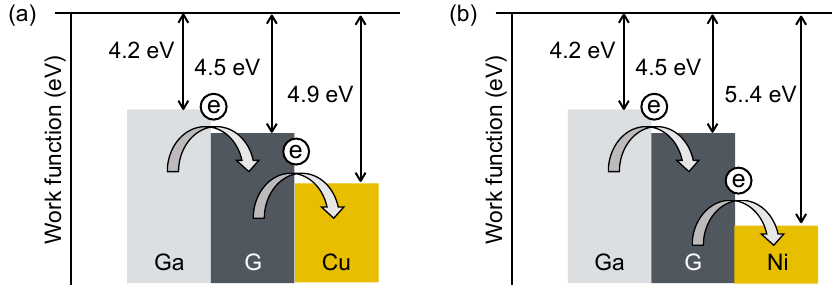
Figure 3. Schema of the work function φ F and of electron transfer in the systems ( a ) Ga NP / G / Cu and ( b ) Ga NP / G / Ni